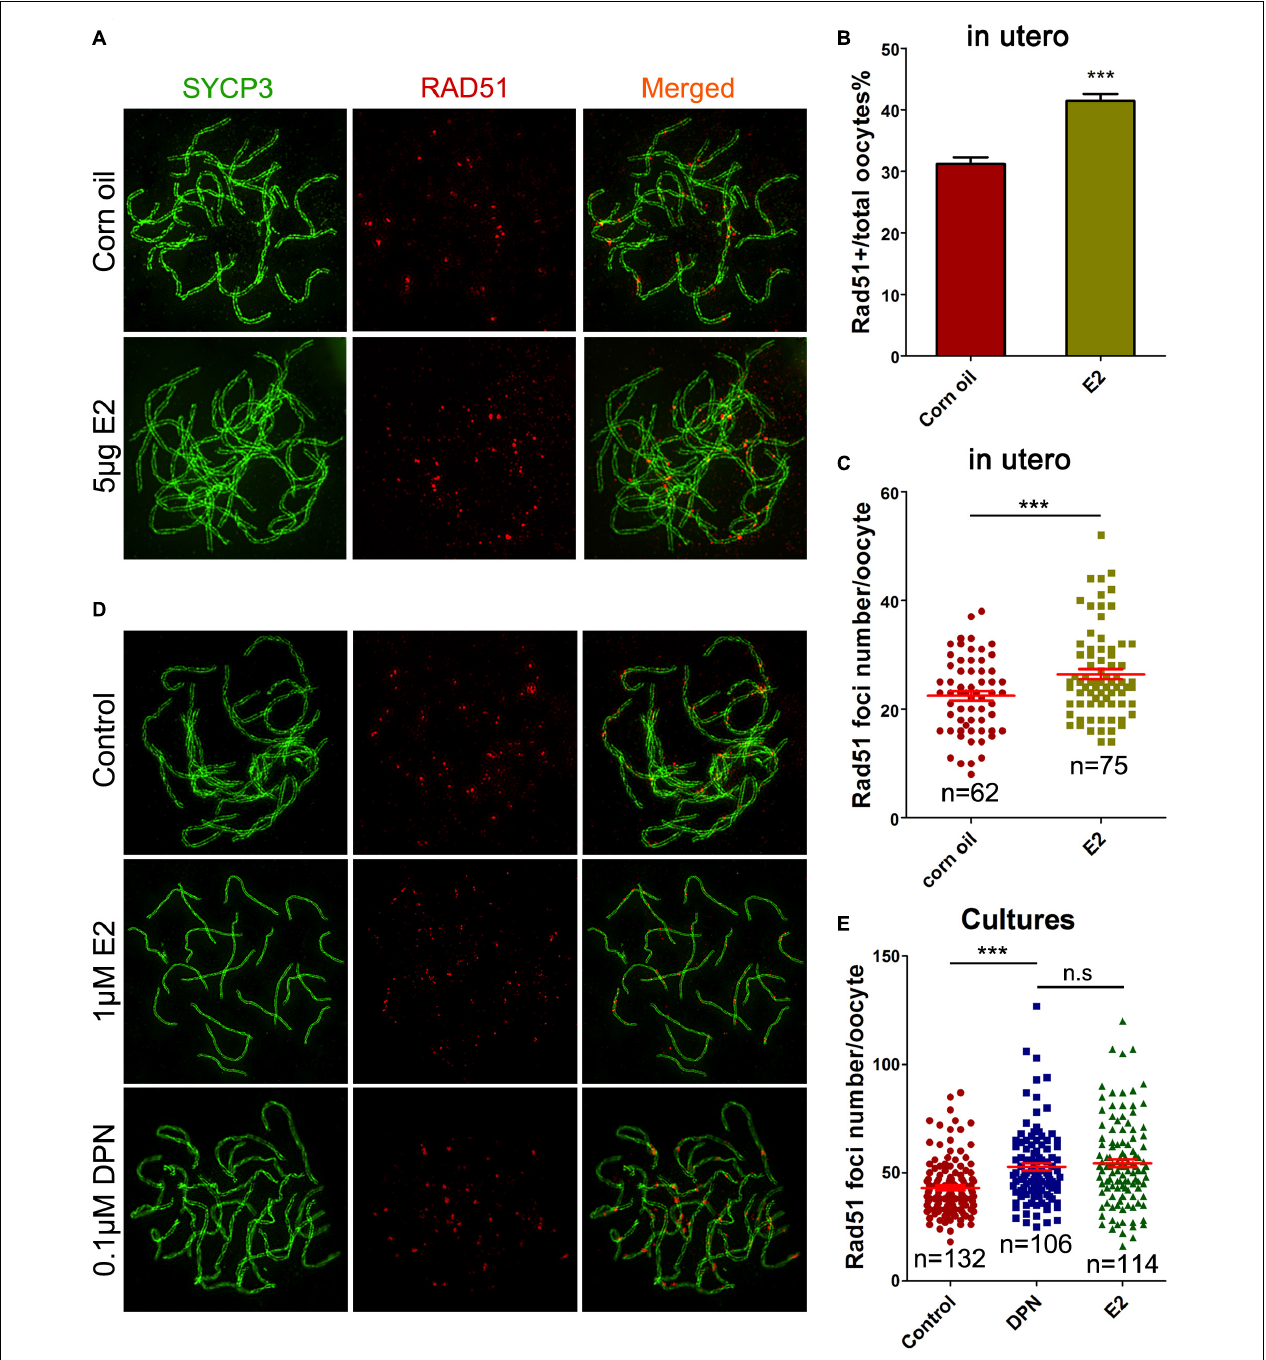
FIGURE 4 | E 2 increases RAD51 foci in fetal oocytes. (A–C) Pachytene oocytes received in utero exposure. (A) RAD51 foci were indicated by co-staining of SYCP3 (Green) and RAD51 (red). (B) E 2 increased the percentage of RAD51-positive oocytes. (C) E 2 increased RAD51 foci number. (D,E) : Pachytene oocytes from ovary culture. (D) Co-staining of SYCP3 (Green) and RAD51 (red). (E) E 2 and DPN increased RAD51 foci number. *** P < 0.001. n.s: not